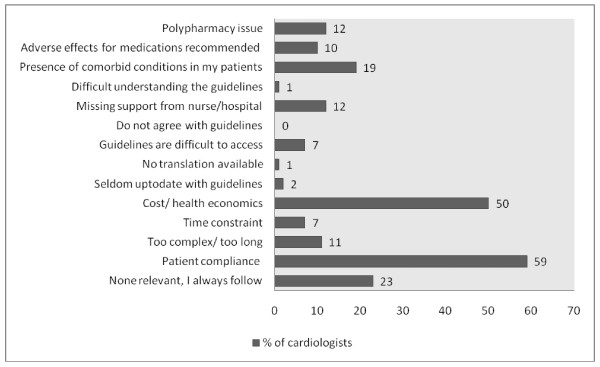
Cardiologists' perception of barriers for adherence to guidelines for CHF.